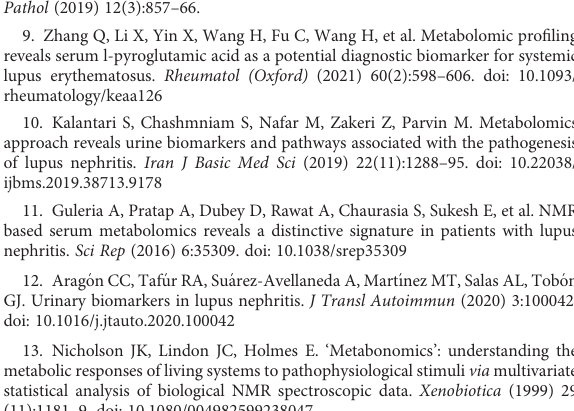
SUPPLEMENTARY FIGURE 1 Total ion chromatogram (TIC) and base peak intensity (BPI) diagrams of positive (A, B) and negative (C, D) ion modes. SUPPLEMENTARY FIGURE 2 PCA score plots of QC samples in positive (A) and negative (B) ion modes among HC, SLE and LN groups. PCA, principal component analysis; HC, healthy controls; SLE, Systemic lupus erythematosus; LN, Lupus nephritis. SUPPLEMENTARY FIGURE 3 Pairwise comparison of the PLS-DA score plots in positive (A, B) and negative (C, D) ion modes between HC and SLE, HC and LN groups. PLS- DA, partial least squares-discriminant analysis; HC, healthy controls; SLE, Systemic lupus erythematosus; LN, Lupus nephritis. SUPPLEMENTARY FIGURE 4 Pairwise comparison of the PLS-DA permutation test plots in positive (A, B) andnegative (C,D) ionmodesbetweenHCandSLE,HCandLNgroups. The criterion for evaluating whether there is over fi tting in the PLS-DA model isthat theregression lineatablueQ2pointcrosses or islessthan0 from the abscissa. PLS-DA, partial least squares discriminant analysis; HC, healthy controls; SLE, Systemic lupus erythematosus; LN, Lupus